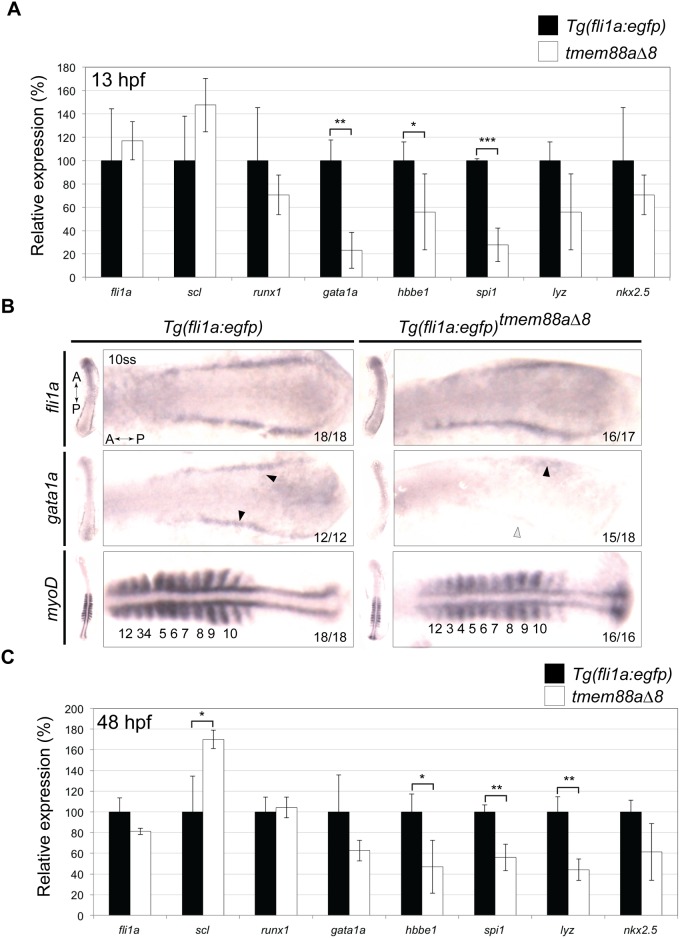
Cardiovascular associated genes are downregulated in tmem88aΔ8 embryos.(A) qRT-PCR showing the expression of key cardiovascular genes in tmem88Δ8 mutants compared to Tg(fli1a:egfp) controls at 13 hpf. (B) In situ hybridisation for fli1a, gata1a, and myoD in control and tmem88aΔ8 mutants as labelled. Gata1a expression is denoted with black error heads, reduced or absent expression is shown with grey or white arrowheads respectively. Somites are marked by asterisks. (C) qRT-PCR showing the expression of key cardiovascular genes in tmem88Δ8 mutants compared to Tg(fli1a:egfp) controls at 48 hpf. All P-values determined by Unpaired Student’s t test. Error bars denote the standard deviation of three biological replicates. P-values determined by Unpaired Students t test. * = p<0.05; ** = p<0.01; *** = p<0.001; unlabelled bars show no significant difference (p>0.05). fli1a, friend leukaemia integration 1a; gata1a, GATA-binding factor 1a; hbbe1, haemoglobin beta-embryonic 1; hpf, hours post fertilisation; lyz, lysozyme; runx1, runt-related transcription factor 1; scl, stem cell leukaemia; spi1, spleen focus forming virus (sffv) and proviral integration oncogene 1b (also known as pu.1).